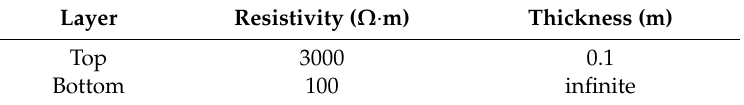
Table 1. Soil model with a granite layer.